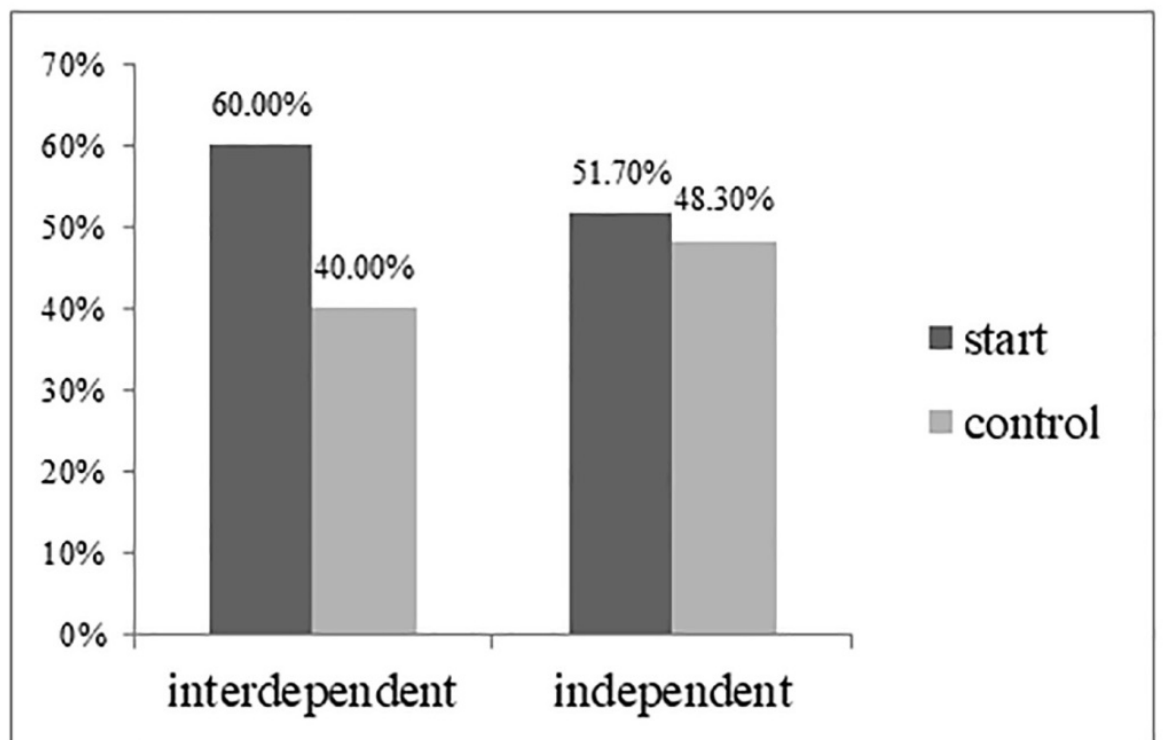
Figure 3. High-arousal drink preferences (Study Figure 3. High ‐ arousal drink preferences (Study 3).